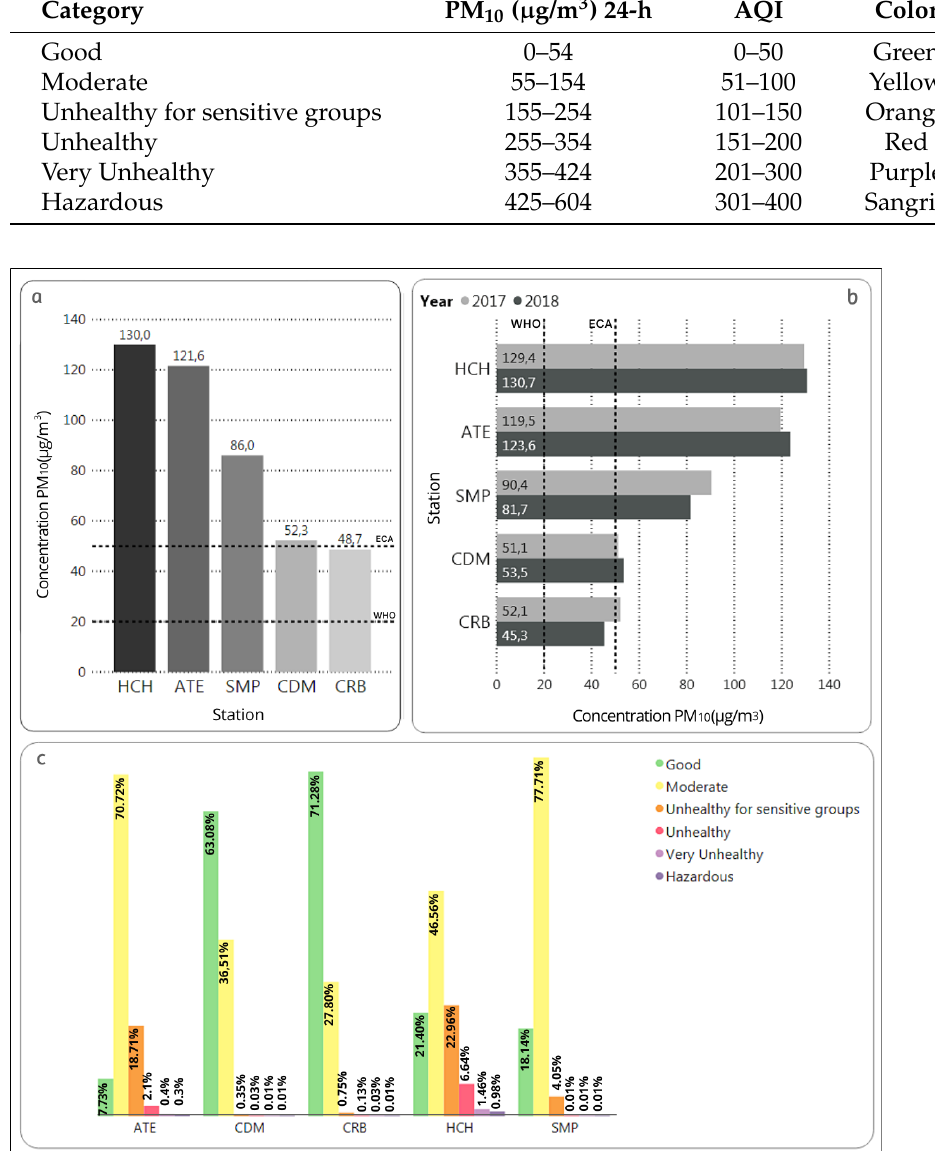
Figure 5. ( a ) Average of the PM 10 concentrations in the period that extends from 1 January 2017 to 31 December 2018. The horizontal lines represent the limit values for annual averages of PM 10 proposed in the ECA in Peru and by the WHO. ( b ) Distribution of the annual averages concentration of PM 10 by station. The vertical lines represent the limit values for annual averages of PM 10 proposed in the ECA and by the WHO. ( c ) Distribution of PM 10 concentration levels by